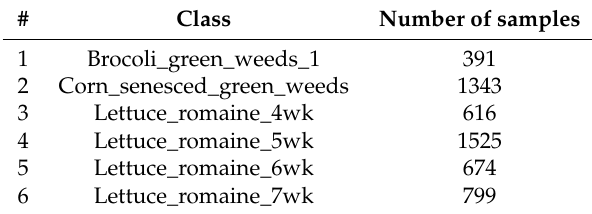
Figure 3. Pseudo-color image ( a ) and ground truth ( b ) of Salinas-A data set. Table 1. Groundtruth classes of the Salinas-A scene and their respective samples